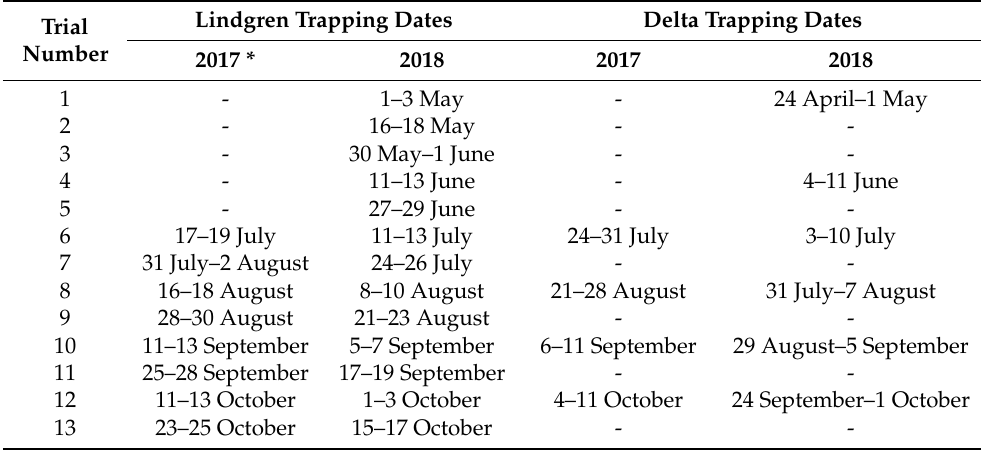
Table 2. Delta and Lindgren trapping dates for 2017 and